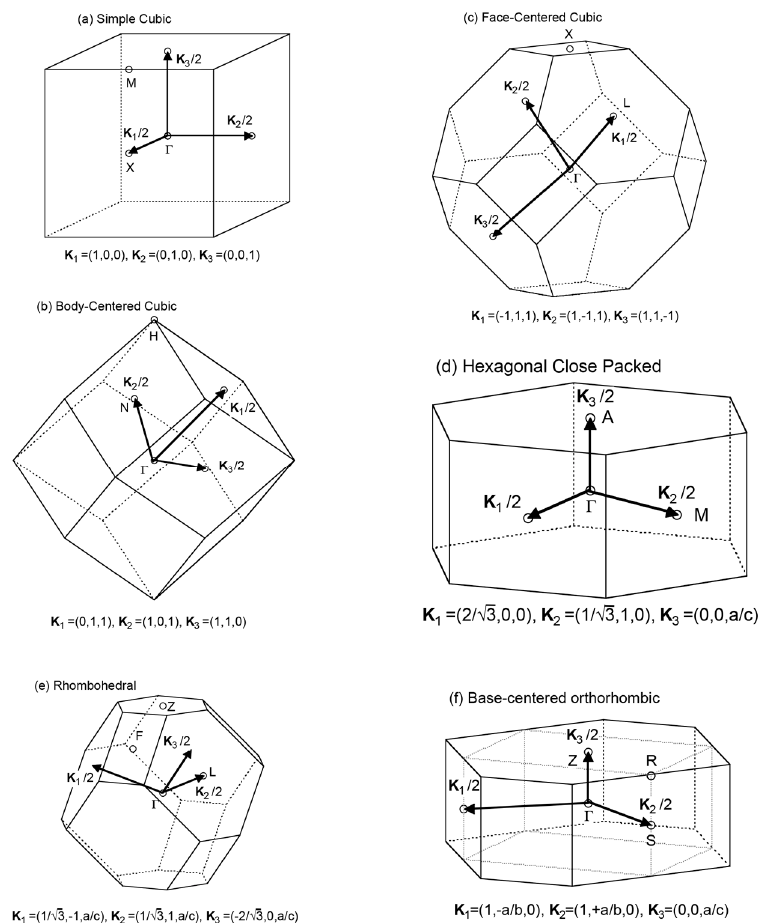
Figure 7. The first Brillouin zone of ( a ) simple cubic (sc) lattice; ( b ) body-centered cubic (bcc) lattice; ( c ) face-centered cubic (fcc) lattice; ( d ) hexagonal close packed (hcp) lattice; ( e ) rhombohedral lattice and ( f ) base-centered orthorhombic lattice.